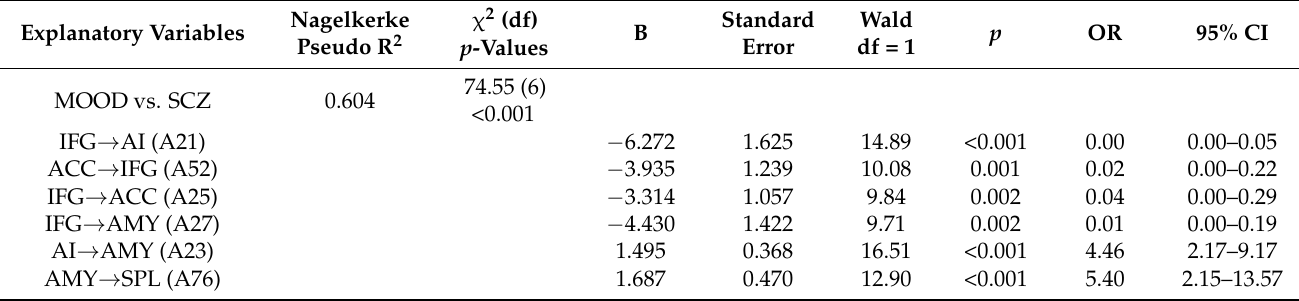
Table 4. Results of binary logistic regression analyses that delineate the connectome features of patient